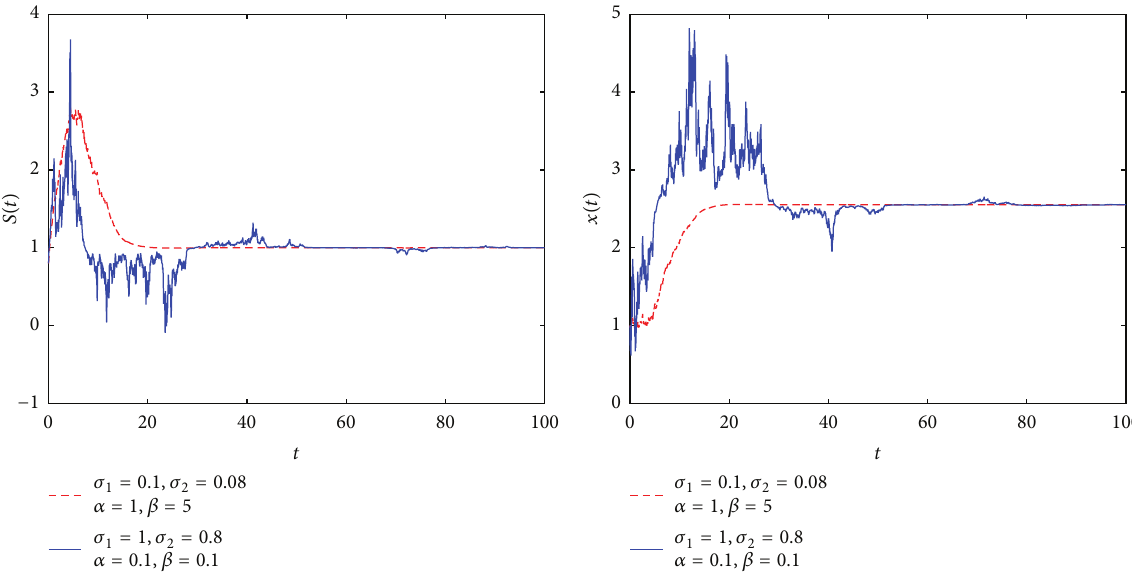
Figure 4: The dynamics of stochastic functional model with different 𝜎 1 ,𝜎 2 and 𝛼,𝛽 . Here 𝑆(0) = 0.3 , 𝑥(0) = 0.5 , 𝑦(0) = 0.3 , 𝑧(0) = 0.5 .